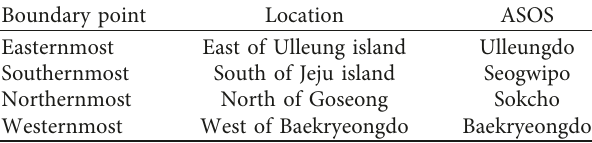
Table 1: Selection of boundary points.